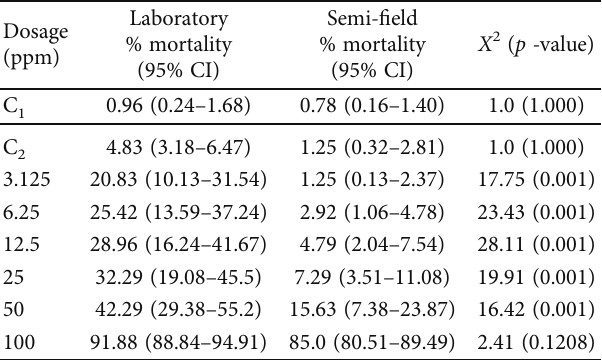
Figure 1: E ff ect of dosage on mortality of An. arabiensis third instar larvae under both laboratory and semi- fi eld environment. Controls: *C1 — water and C2 — aqueous solution of 1ml acetone. Table 2: Mortality by dosage in both laboratory and semi- fi eld environment for An. arabiensis